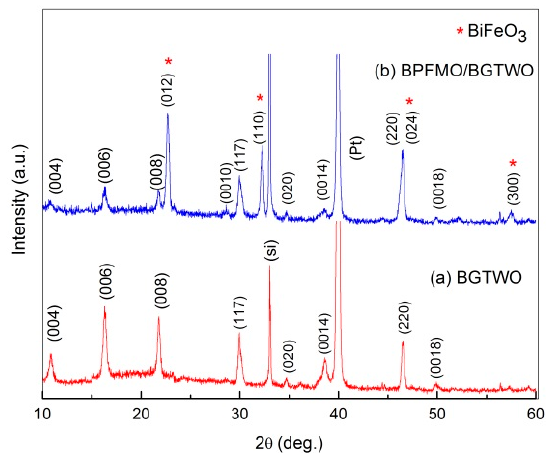
Figure 1. XRD spectra of ( a ) a pure BGTWO film and ( b ) a BPFMO/BGTWO bilayer thin film. The surface microstructure of the BPFMO, BGTWO and BPFMO/BGTWO bilayer films, and a cross